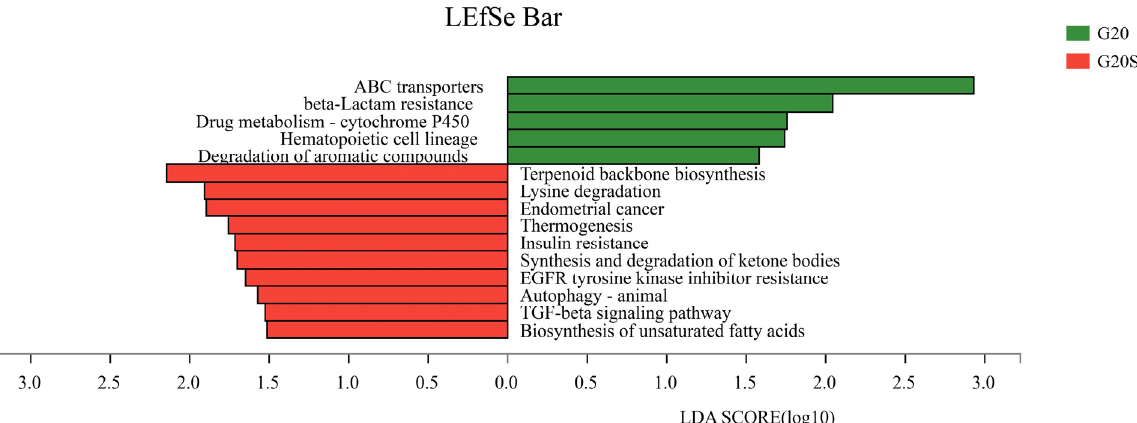
Figure 7. Differential analysis of KEGG metabolic pathways between the G20 (noninoculation) and G20S (strain SR-9 inoculation)